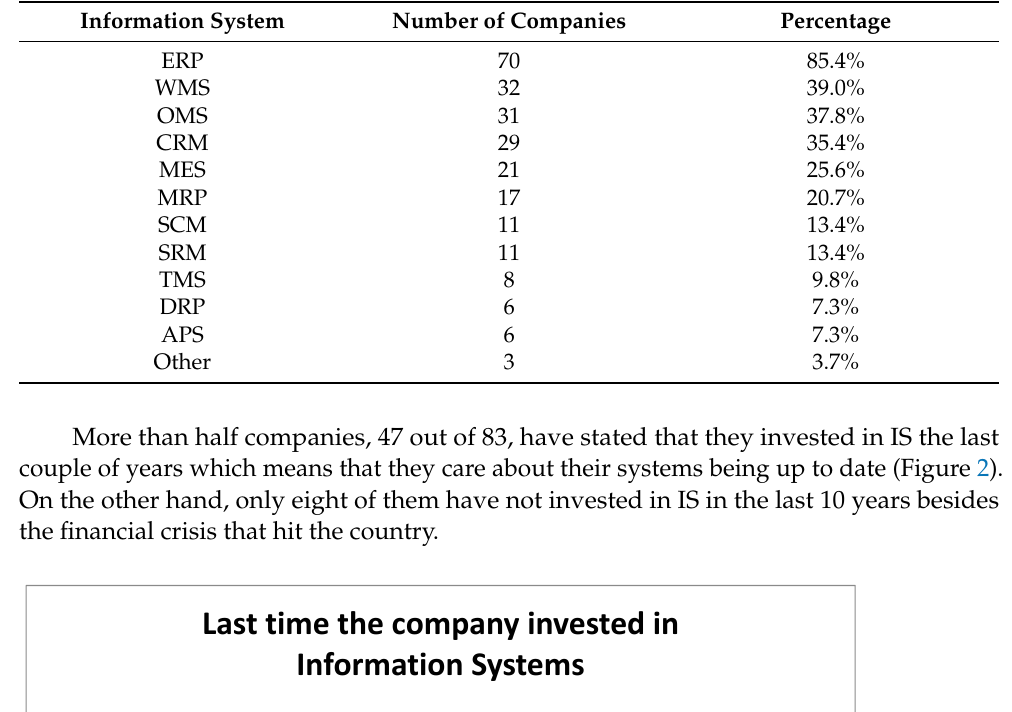
Table 2. Information systems in use.